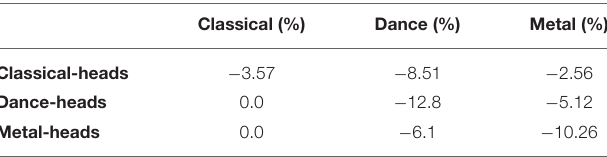
TABLE 4 | Example of Matrix C, the feature-influence matrix, showing the percentage Valence change of three genres downloaded by three X-head